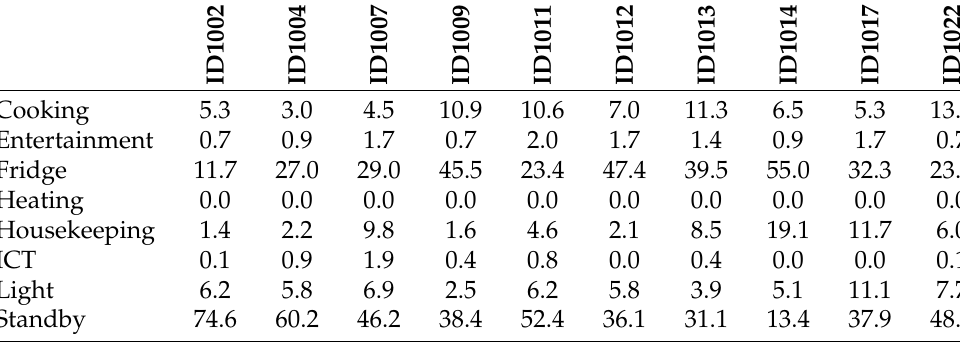
Table 13. Load disaggregation results for German households: predicted Energy Share [%] per category.